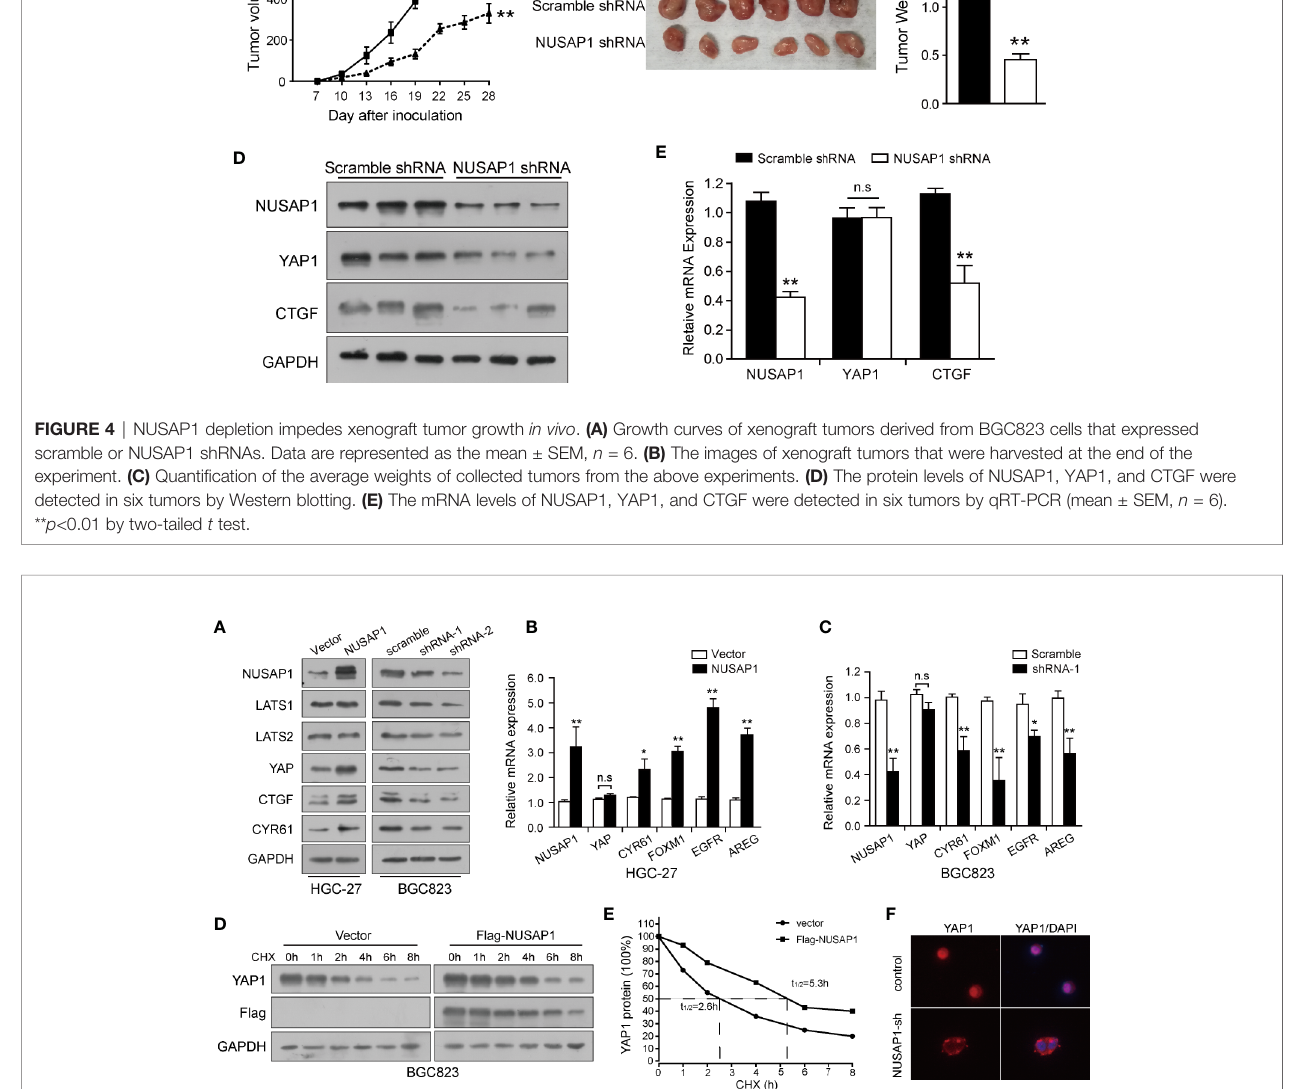
FIGURE 5 | NUSAP1 orchestrates the Hippo pathway by stabilizing YAP1 protein. (A) Western blotting analysis to evaluate LATS1/2, YAP1, and YAP1 downstream target genes CTGF and CYR61 in lysates prepared from modi fi ed cell lines HGC-27 and BGC823. GAPDH was used as a loading control. (B, C) qRT-PCR analysis of YAP1 and its downstream target genes CYR61, FOXM1, EGFR, and AREG in modi fi ed HGC-27 and BGC823 cells. Relative expression is shown over GAPDH mRNA. (D) Western blotting analysis of YAP1 protein in modi fi ed BGC823 cells treated with CHX (25 m g/mL) for the indicated times. (E) The line graph shows YAP1 levels normalized to GAPDH at the indicated time points. (F) Immuno fl uorescence of YAP1 in modi fi ed BGC823 cells showing cellular localization. Student ’ s t test: * p <0.05, ** p